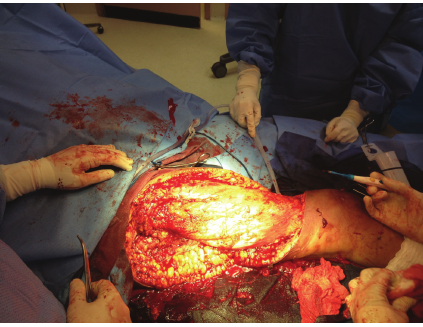
Figure 2: Surgical debridement revealing extensive area of necro- tizing fasciitis on anterior, medial, and lateral right thigh involving epidermis, dermis, subcutaneous tissue, and